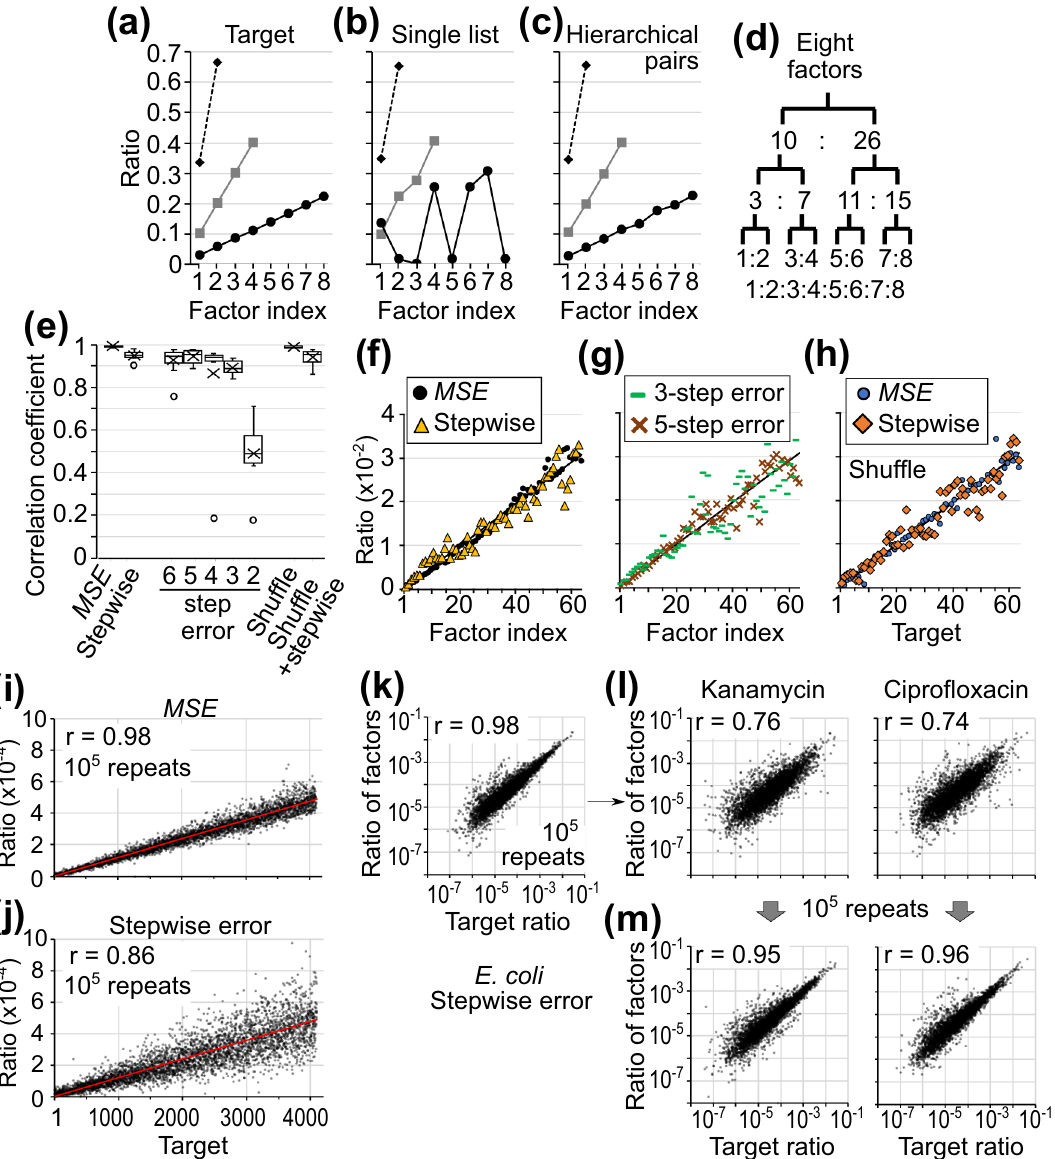
Figure 2. Regulation of multiple factors by using hierarchical pairs and approximated error. ( a – d ) Stochastic processes of competitive amplification with β = 1 and MSE -dependent decay are repeated in the model with two, four, and eight factors. ( a ) Target ratios of each factor in three simulation conditions are shown as three lines with markers. ( b ) Competition and MSE are calculated in one list that include all factors. The ratios of each factor after 10 6 repeats are shown. ( c , d ) The ratios of eight or four factors are determined by hierarchical pairs ( d ). Each pair independently repeats the stochastic processes 10 5 times. ( e – h ) The results after 10 5 repeats in the model regulating 64 factors in hierarchical pairs. In MSE , the error is calculated with full accuracy. In “stepwise”, MSE is rounded every 10 folds. The number of steps of error ( g ) indicates the possible error levels. In “shuffle” ( h ), the factor with each target value is randomly set in the hierarchical pairs. In ( e ), correlation coefficient between the target and result ratios in 10 tests are shown in box and whisker plots indicating the interquartile range, 1.5 × the interquartile range, the mean (cross), and the data in outlier region (circle). Black lines in ( f – h ) indicate the target ratios. ( i – m ) The results in the model with 2 12 factors after 10 5 repeats. Accurate MSE ( i ) or approximated stepwise error ( j – m ) is applied to decay probability. ( i , j ) The factor with each target value (range 1–4096 as indicated by a red line) is randomly set in the hierarchical pairs. ( k ) The target ratio is set using the expression ratio in E. coli without antibiotics. Initial condition of pairs is an even distribution. ( l , m ) Subsequently, from the ( k ) state, the target ratios for the next 10 5 repeats are reset using gene expression data in the presence of antibiotics. The ratios of the factors before ( l ) and after ( m ) the second 10 5 repeats are shown, where r is the correlation